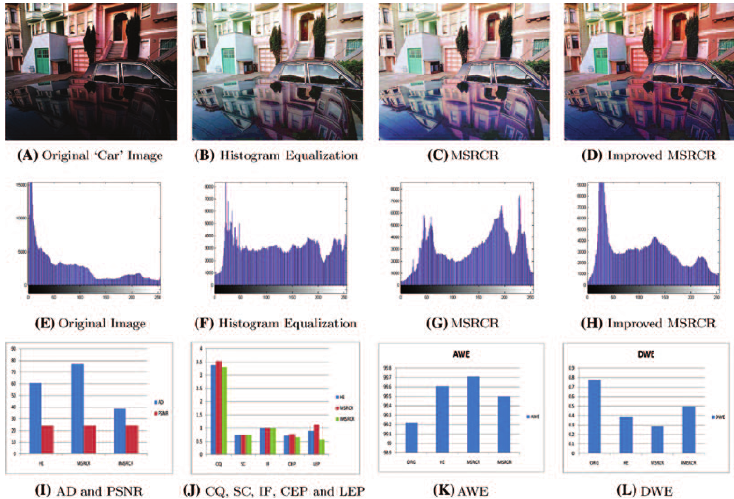
Figure 5. (Top) Image Enhancement Methods. (Middle) Histogram Plots: x -axis, Intensity Levels Ranging from 0 to 255; y -axis, Total Number of Pixels. (Bottom) Conventional Metrics and Proposed AWE and DWE Metrics. The “Car” Image has been Downloaded from http://visl.technion.ac.il/1999/99-07/www/.